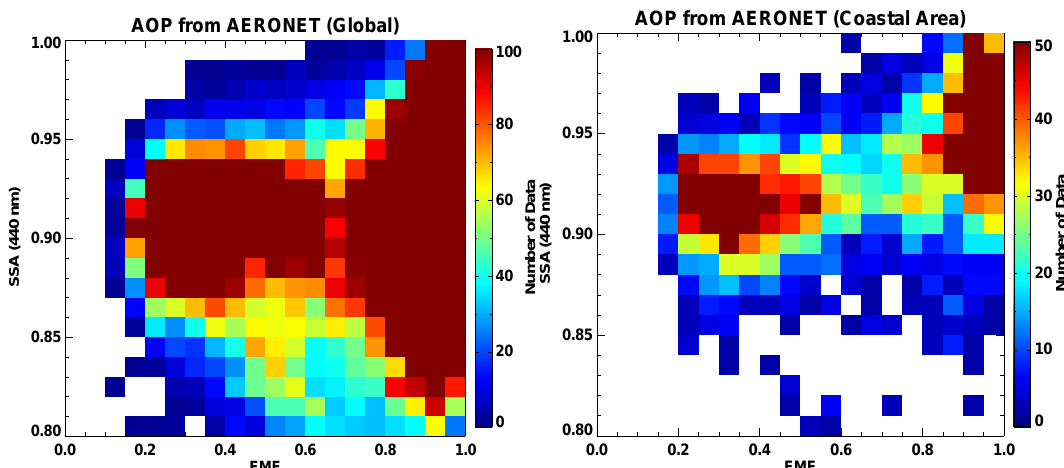
Fig. 3. The number of data points included in each FMF (550nm) and SSA (440nm) bin, archived from the AERONET inversion data over the globe (left) and coastal areas (right). The data were sorted into intervals of 0.05 and 0.01 for FMF and SSA, respectively. The AERONET stations in the coastal area are shown in Fig. 2.